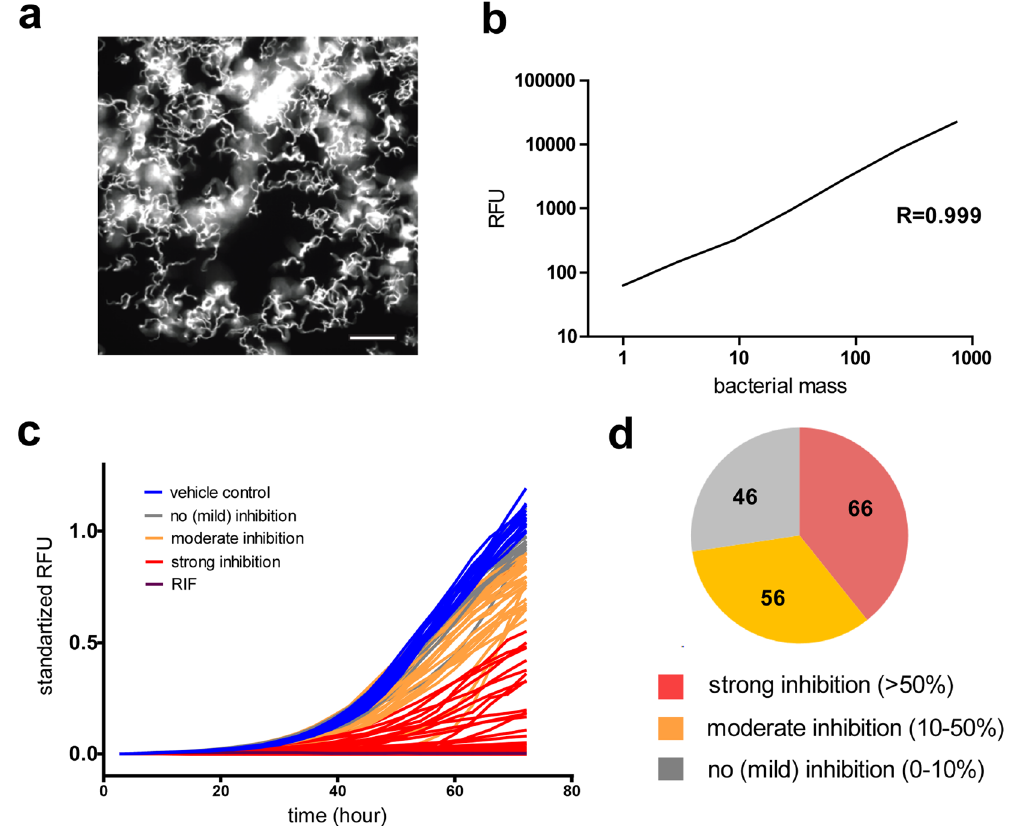
Figure 1. Characterization of antibiotic activities of GSK TB-set compounds. ( a ) Fluorescent confocal microscopy of 10 5 M. marinum msp12::GFP, 72 hours incubation time in 7H9 broth. The scale bar corresponds to 20 µ m. ( b ) Correlation between fluorescence intensity and serial dilution. Serial dilutions of M. marinum msp12::GFP, were transferred to 96-well plate. Dilution factor is 3. A relative density unit corresponds to 10 5 bacteria. ( c ) Growth kinetics of M. marinum msp12::GFP in 7H9 broth and in the presence compounds from GSK TB-set (color-coded green) of vehicle control (blue), supplemented with 10 μ M amikacin (purple), 10 μ M rifabutin (red) representative experiment from a series with similar outcome. 10 5 M. marinum expressing GFP were transferred to the wells. Fluorescence intensities were measured for 72 hours every 3 hours. ( d ) Pie chart representing summarized results of growth inhibitory activity of 168 compounds in M. marinum growth assay. The analyzed set included compounds that displayed inhibition of more than 90% RFU (red), inhibition between 30 and 90% (orange), compounds that showed less than 30% inhibition